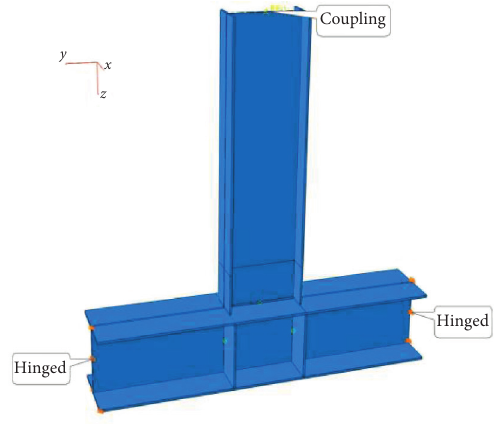
Figure 3: Boundary conditions of the finite element